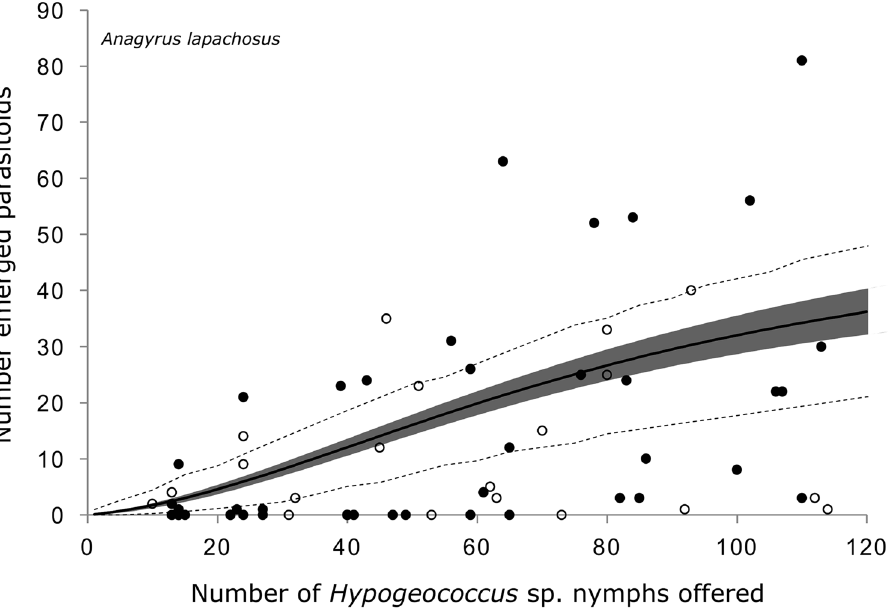
Figure 2. Observed functional response of the parasitoid Anagyrus lapachosus attacking Hypogeococcus sp. nymphs. Solid line indicates the mean estimation of functional response, grey area indicates its credibility interval, and dashed line indicates the a posteriori credibility interval for individual measurements. White circles are the observed number of emerged parasitoids in interaction experiments, while dark circles are the number of parasitoids emerged in experiments without